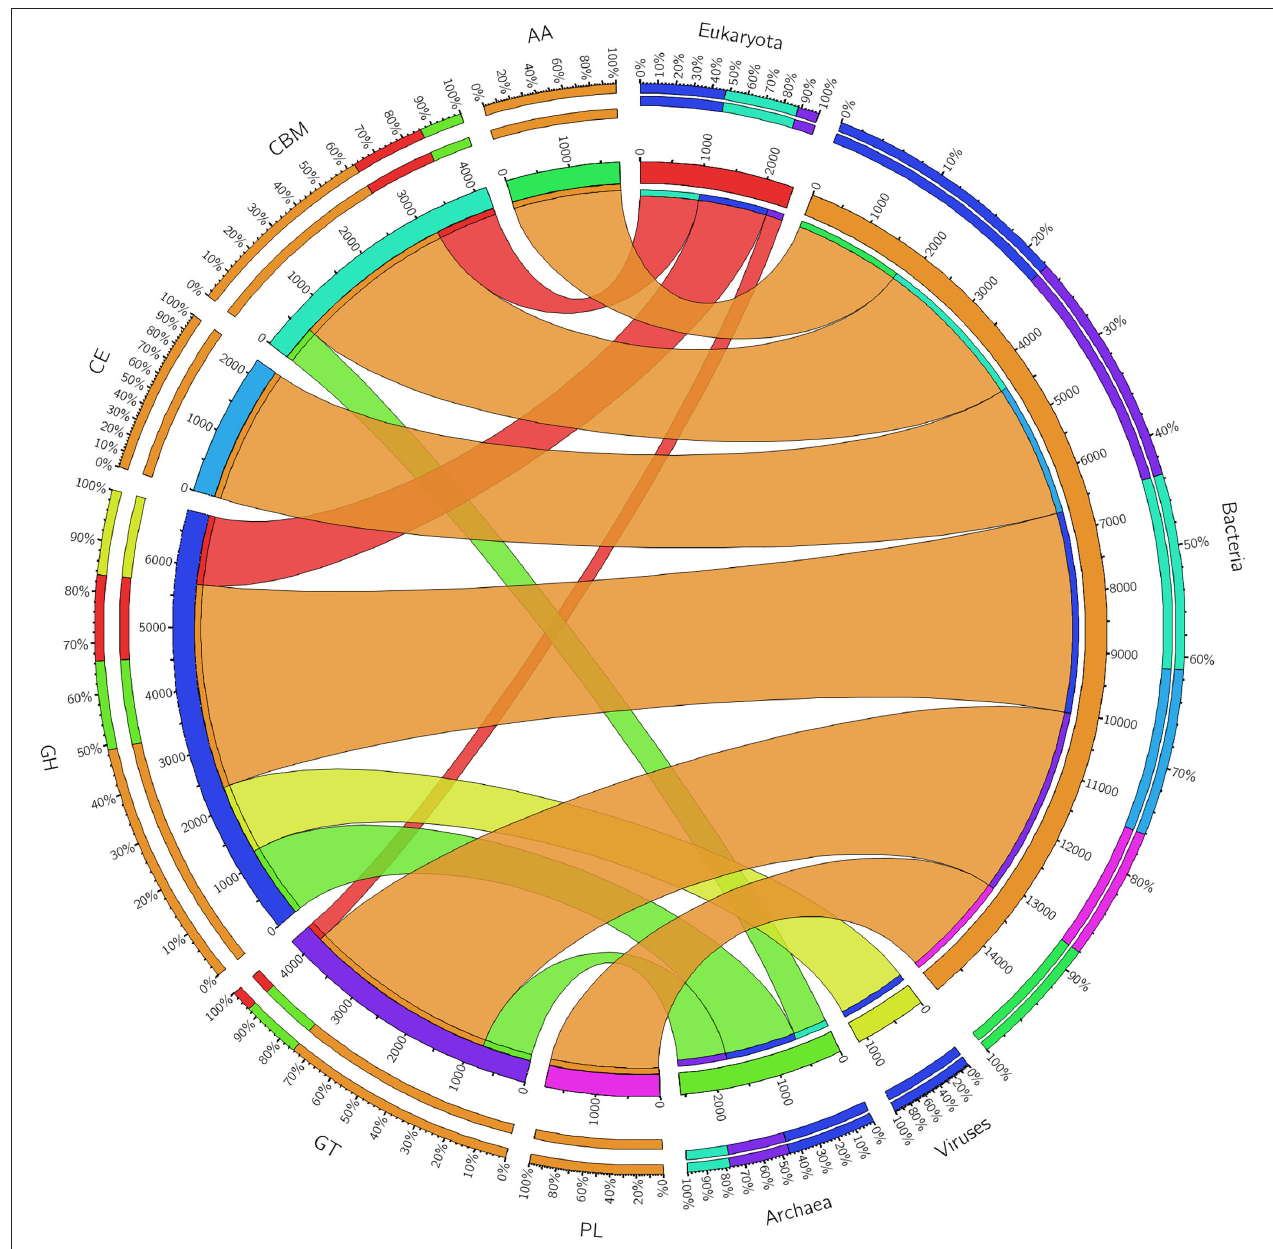
FIGURE 8 | Circos plot representation of the carbohydrate-active enzymes of BS14 at the Kingdom level.